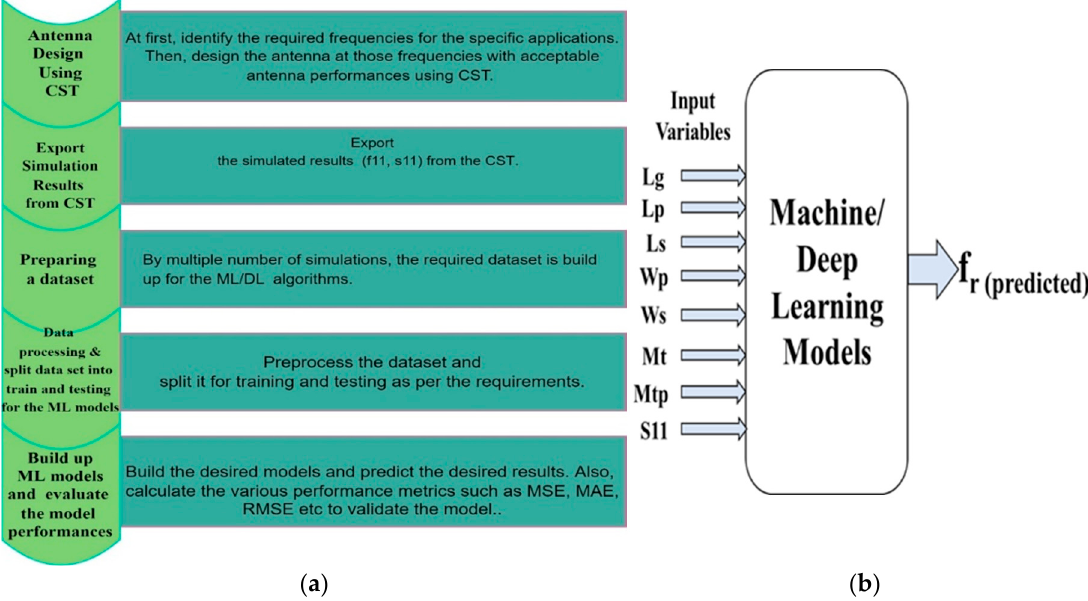
Figure 11. ( a ) Flowchart for ML/DL-based antenna results prediction; ( b ) analysis of MPA using ML/DL models. Table 3. Simulated and predicted resonant frequency comparison of the test set using